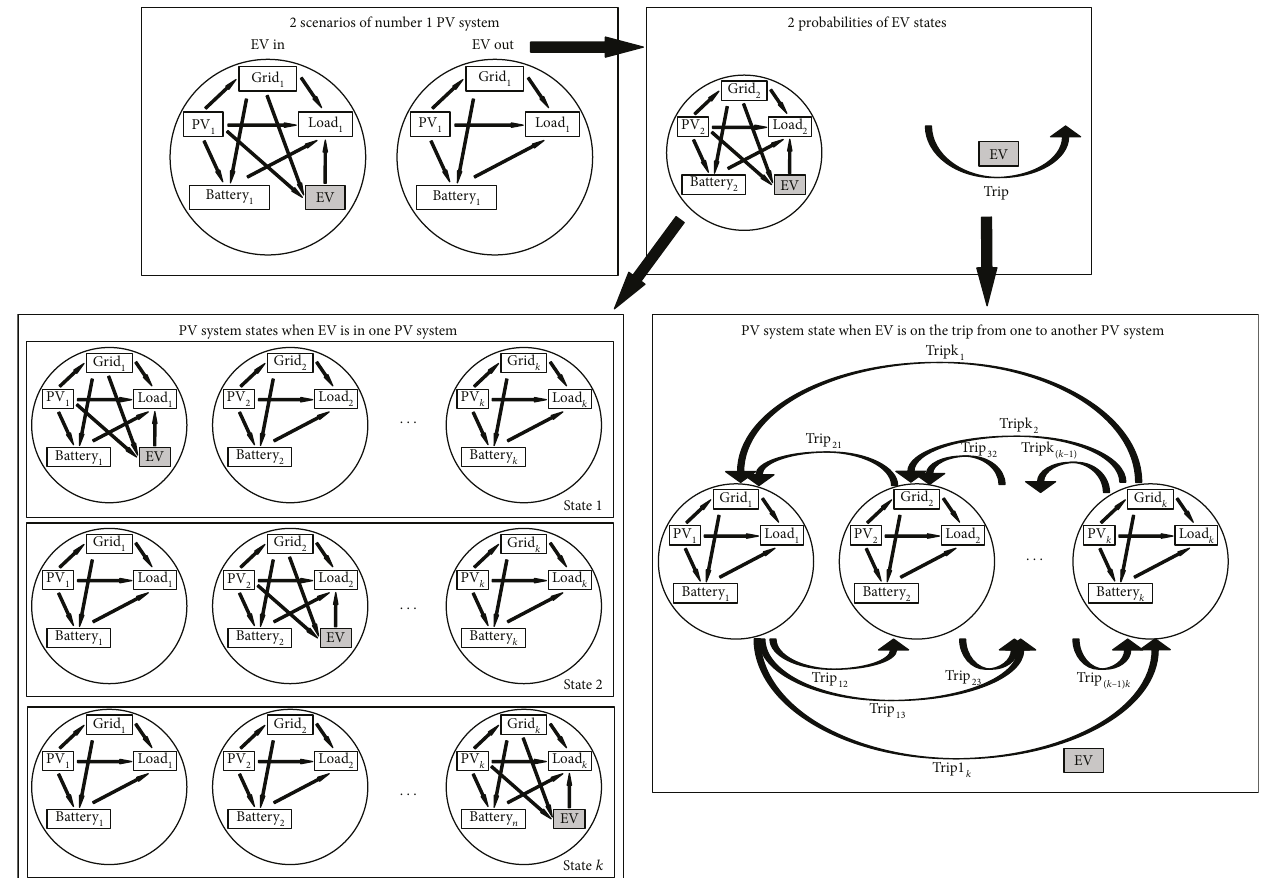
Figure 1: Scenarios of the distributed PV systems with EV multiple-mode application.